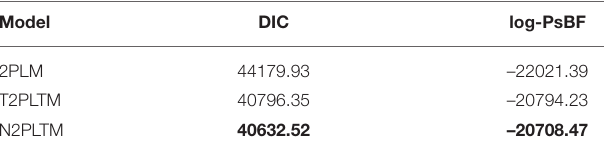
TABLE 7 | The results of Bayesian model assessment in the real